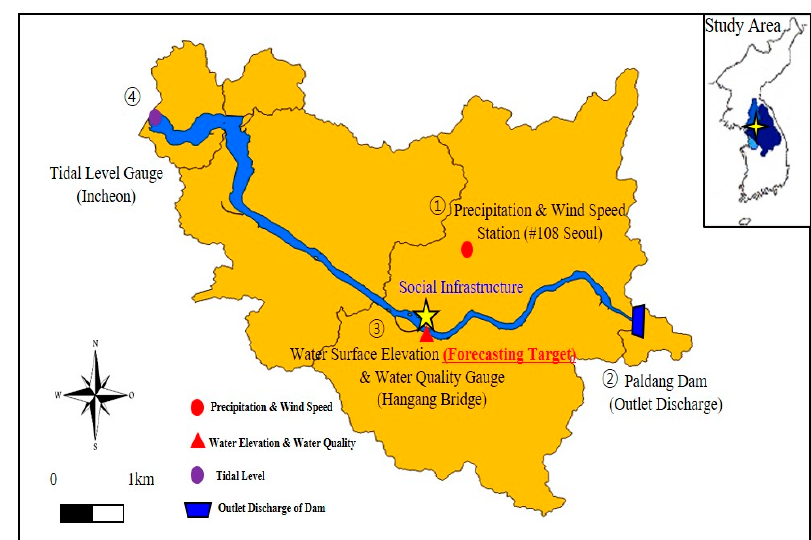
Figure 2. Study area (Hangang River).